Question: State the chart type depicted above.
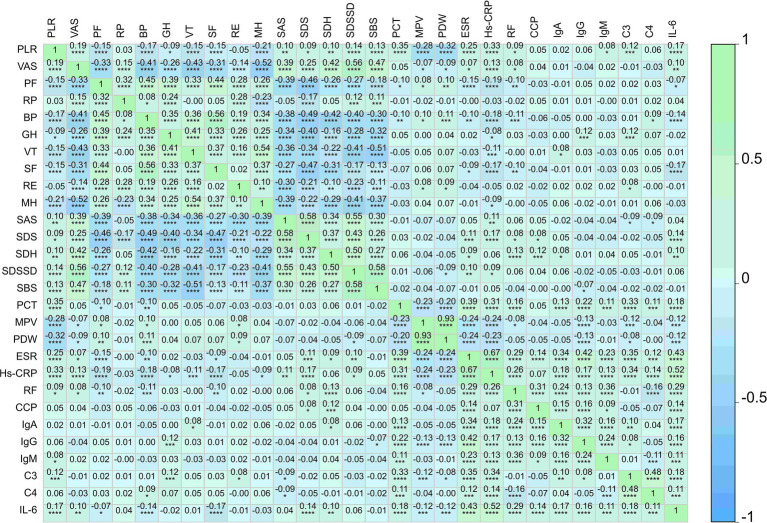
Answer: heatmap